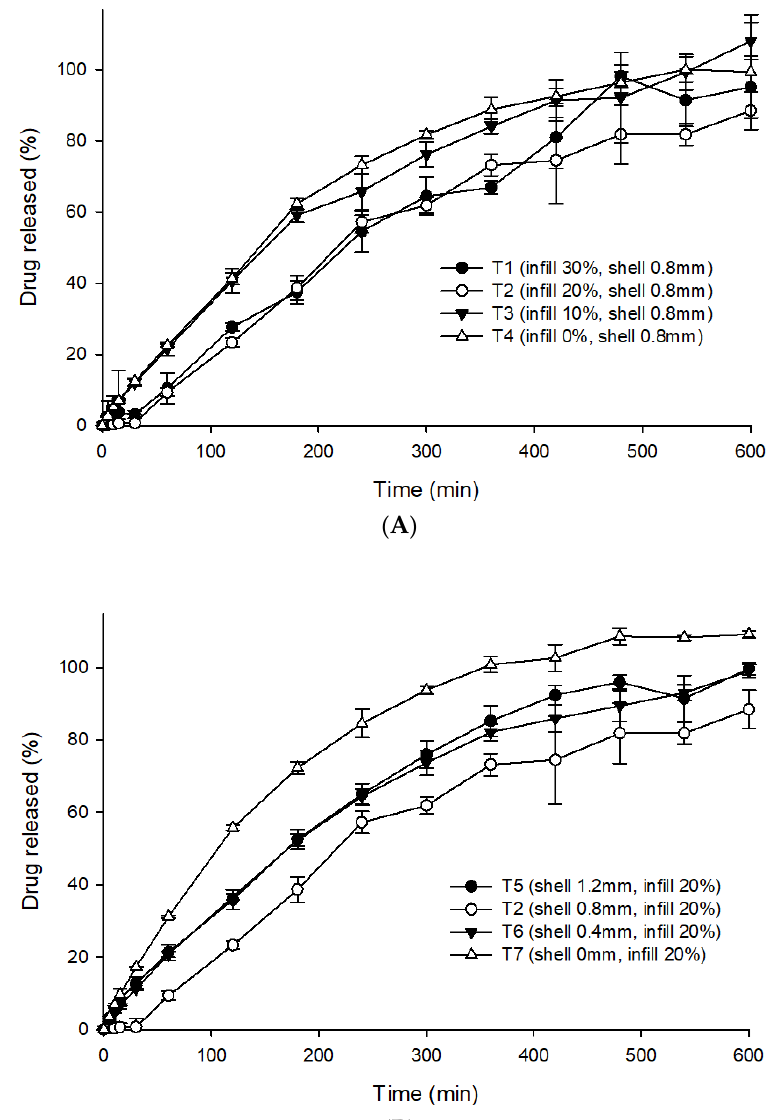
Figure 6. Drug release profiles of the 3DP tablets; ( A ) showing the influence of the infill percentages and ( B ) showing the influence of the shell thickness. Each value represents the mean ± standard deviation ( n = 3).